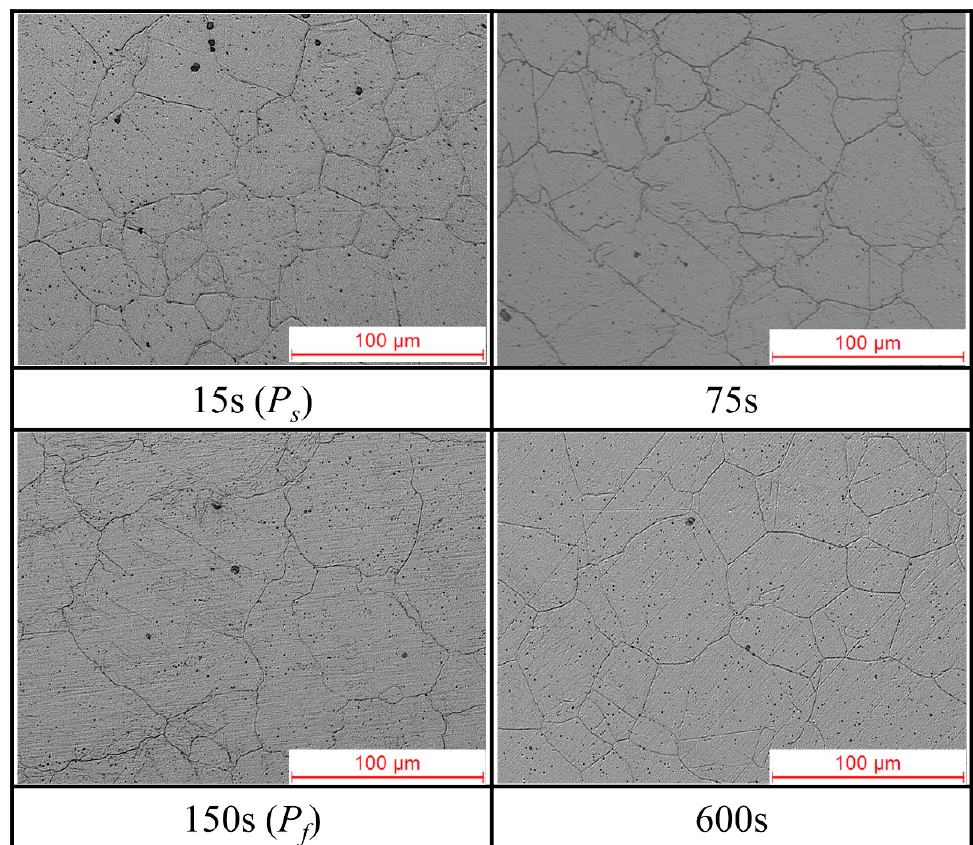
Figure 8. Evolution of the austenite grain of Ti microalloyed steel deformed at 900 °C and held for different times .